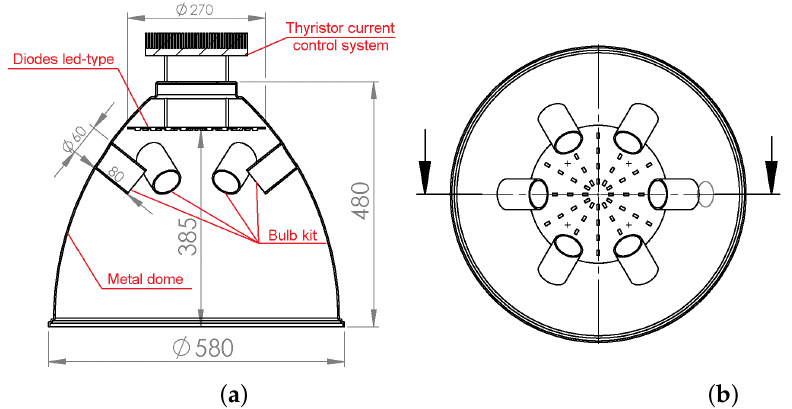
Figure 1. Solar simulator (the upper part of the test bench): ( a ) cross-section, ( b ) bottom